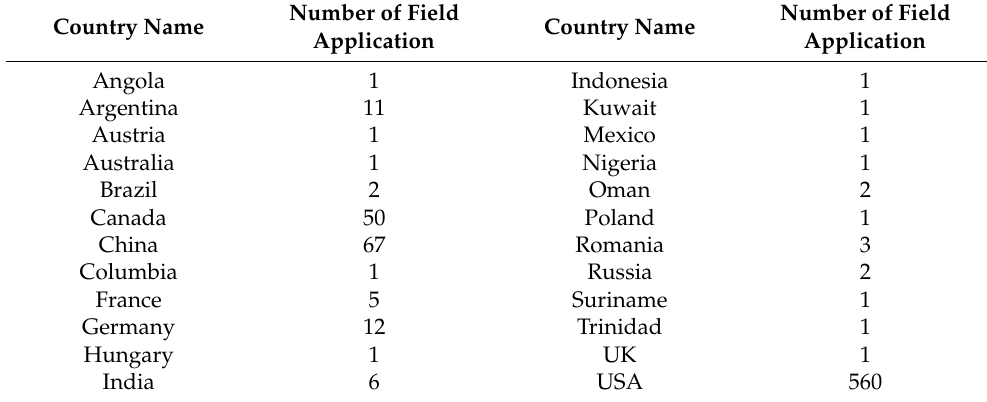
Table 2. A list of 733 polymer-flooding projects worldwide (Adopted from Sheng, 2015 [56]). Number of Country Name